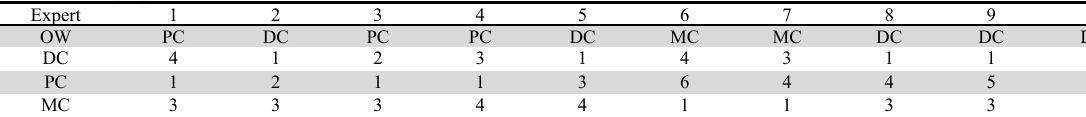
Main challenge preferences (Others to worst) Expert